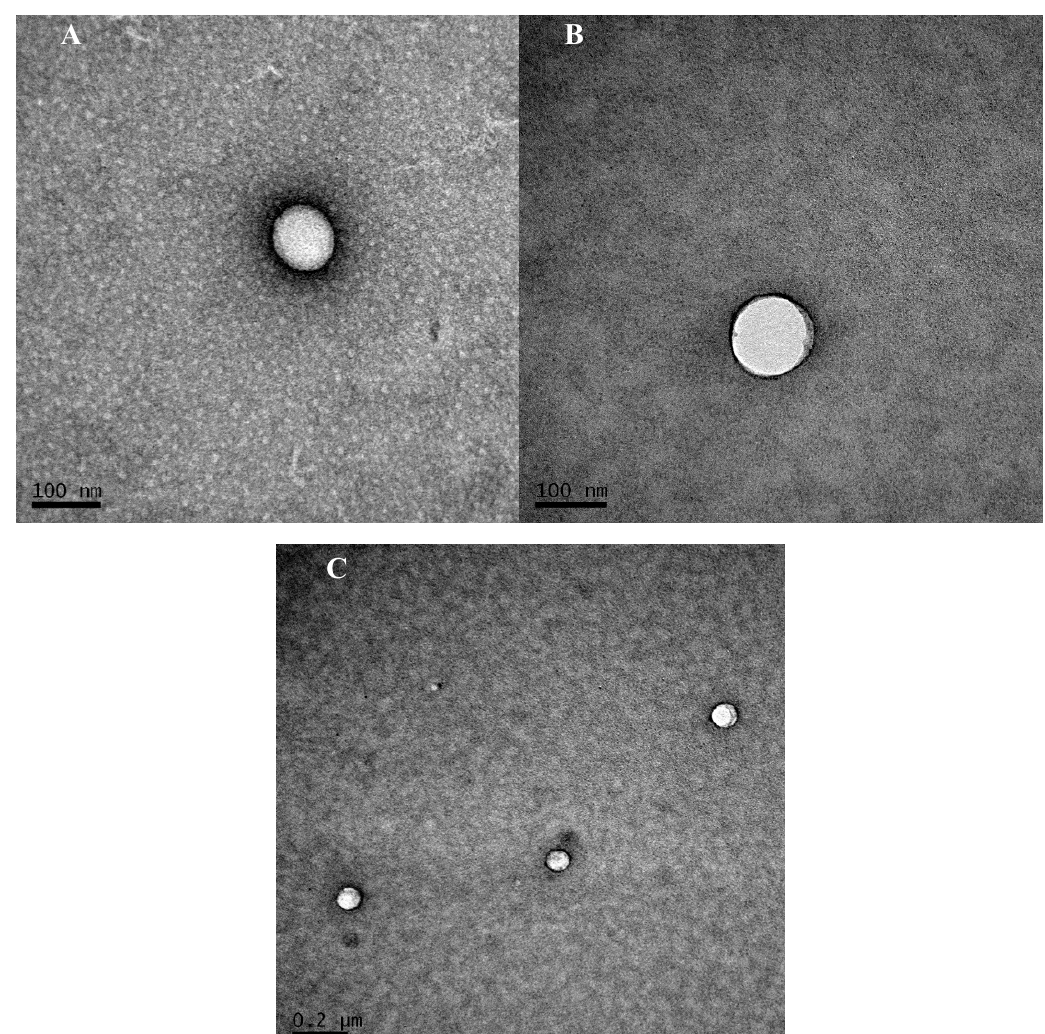
Figure 1. TEM images of the nanoparticles developed. Image ( A ) shows gelatin nanoparticles (GNP), whereas images ( B , C ) corresponds with TM-GNP.